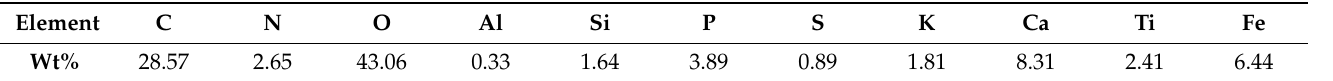
Table 9. EDX data of